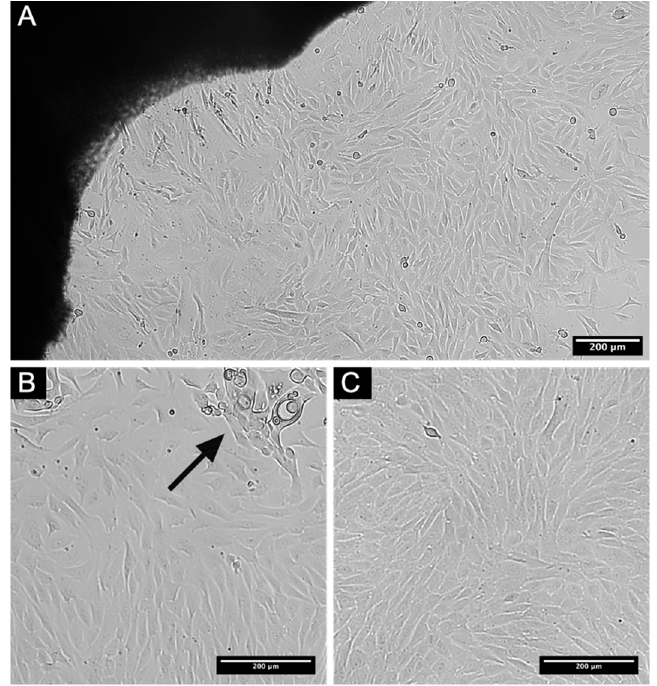
Figure 1. Phase-contrast microscopy of cell culture isolated from rabbit corneo-scleral rims. ( A ) Primary culture isolated from rabbit limbus. Cells appear elongated with single nucleus. ( B ) 21 days of cultivation of primary culture. Cell monolayer was formed. Arrow marks cells of epithelial morphology. ( C ) Established homogenous cell culture after 3rd passage. Scale bars: ( A – C ). 200 micrometers ( μ m).